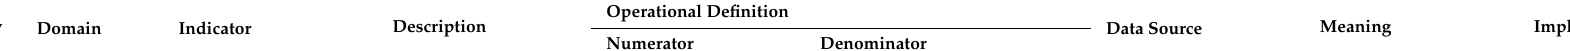
Table 2. Indicators of Age-Friendliness in Taiwan’s